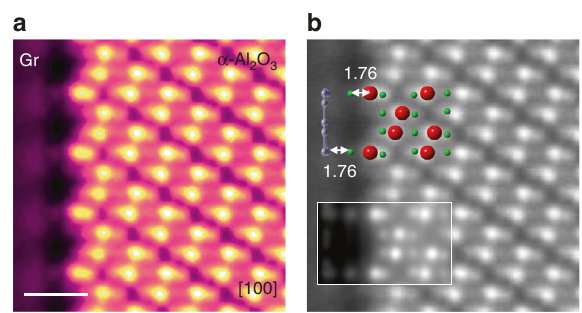
Fig. 1 Atomic structure of the Gr/ α -Al 2 O 3 interface. a HAADF image viewing along the [100] orientation. The image is colored to clearly show the interface structure. b The corresponding ball and stick model and simulated image. The unit of length is Å. Scale bar: 0.5 nm. Red: Al atom. Green: O atom. Gray: C